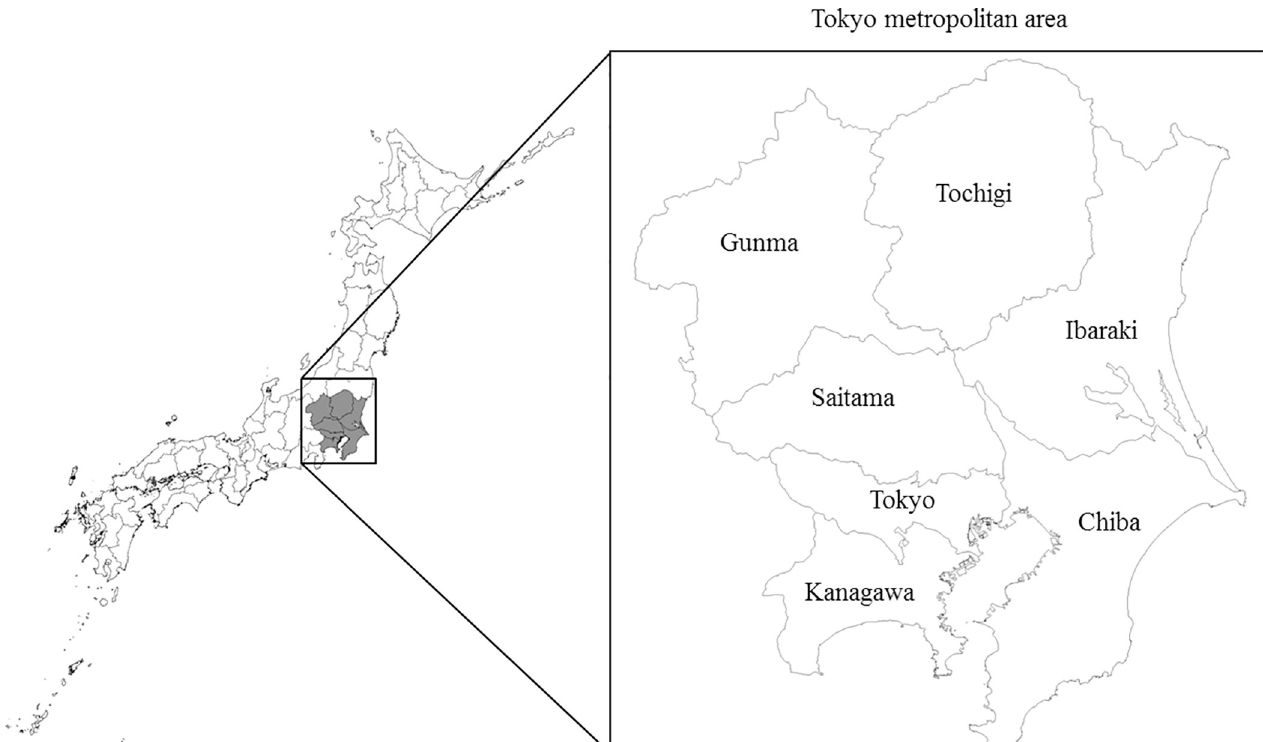
Fig 1. Seven prefectures in the Tokyo metropolitan area.